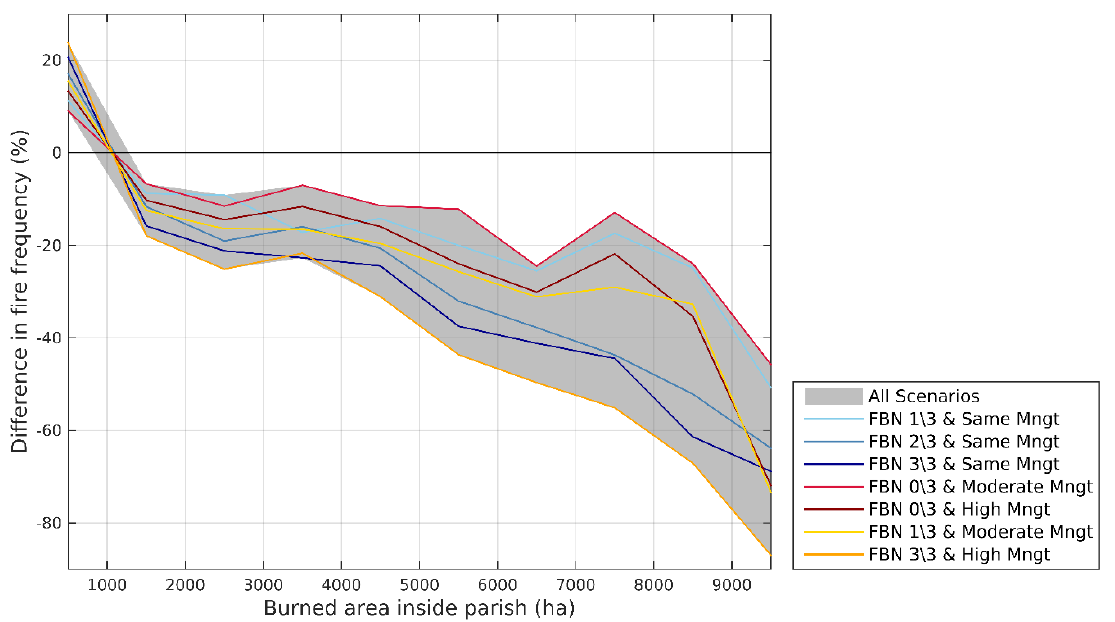
Figure 11. Impact of fuel management scenarios on the burned area extent inside the Alvares parish. “FBN” stands for fuel break network; “Mngt” stands for management.